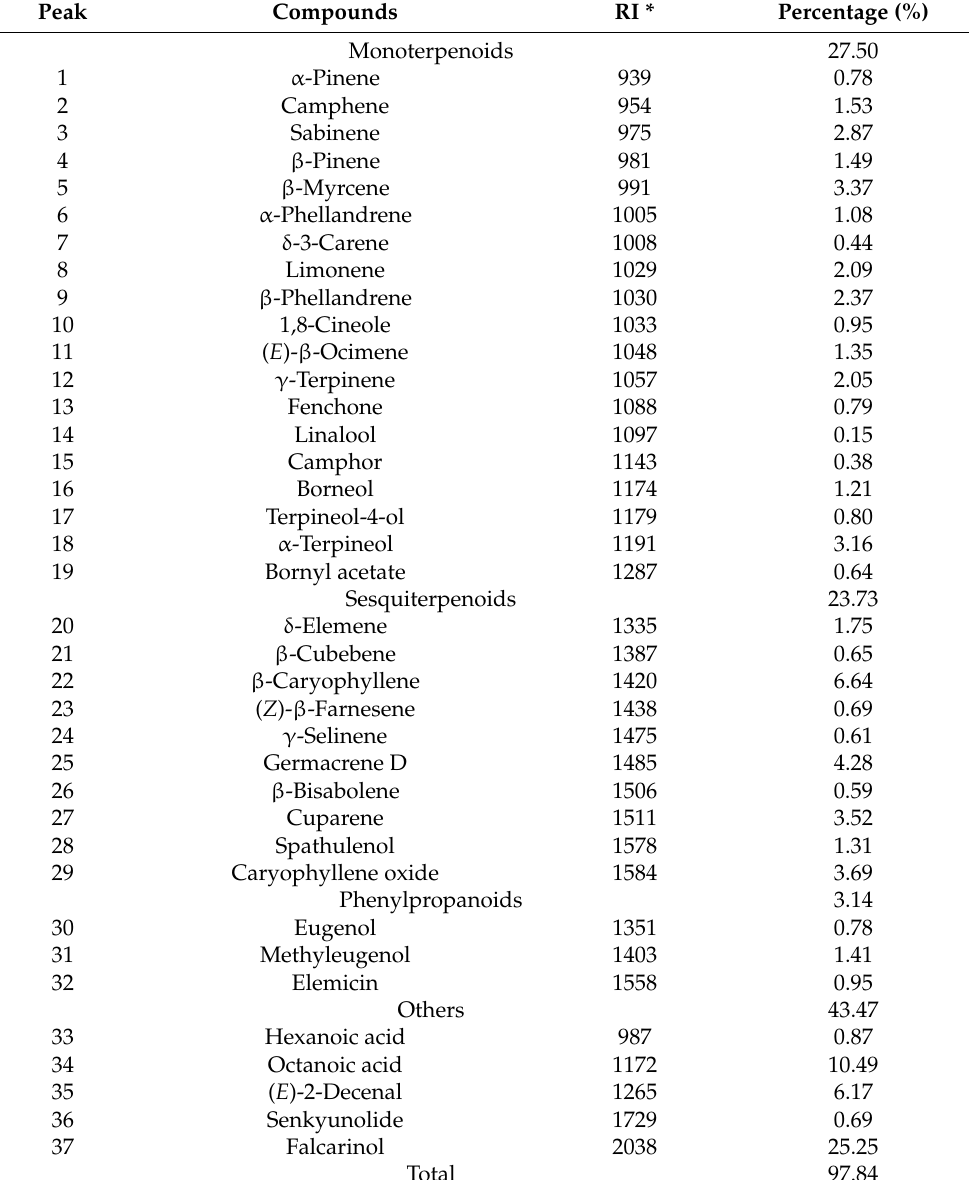
Table 1. Chemical components of the EO isolated from Seseli mairei H. Wolff